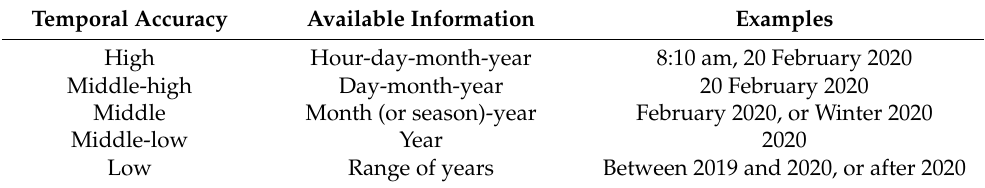
Table 1. Temporal accuracy